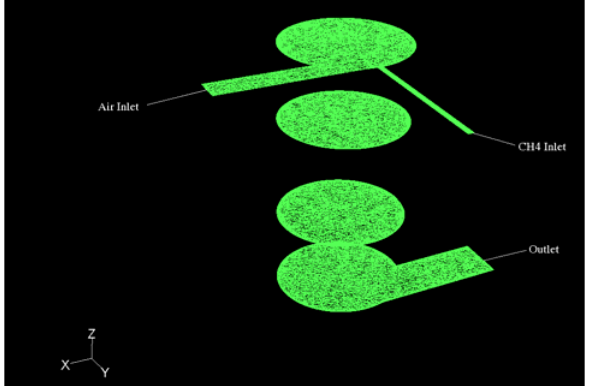
Figure 1. Representative geometry of the micro-combustion chamber.